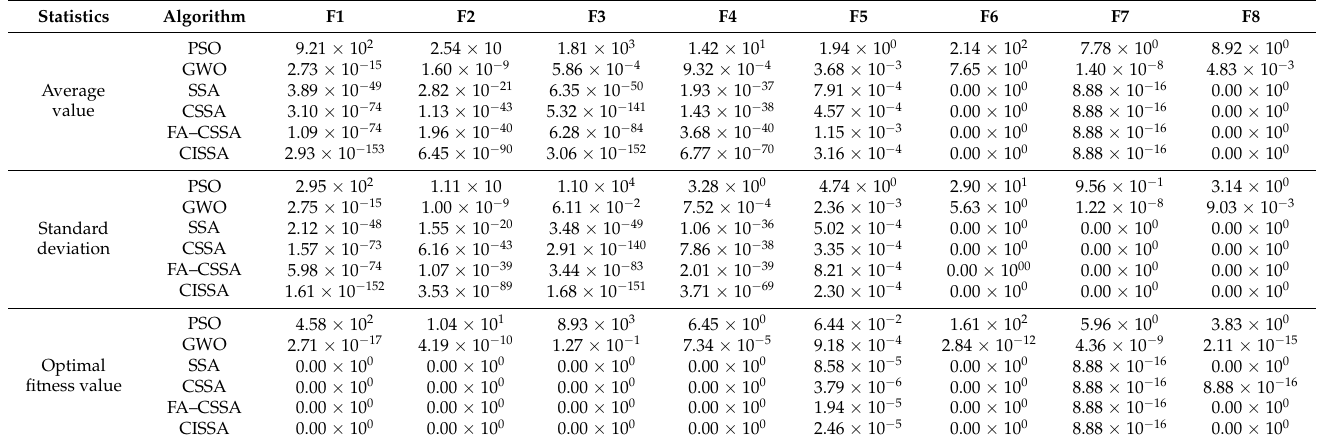
Table 4. Optimal results of different intelligent algorithms.